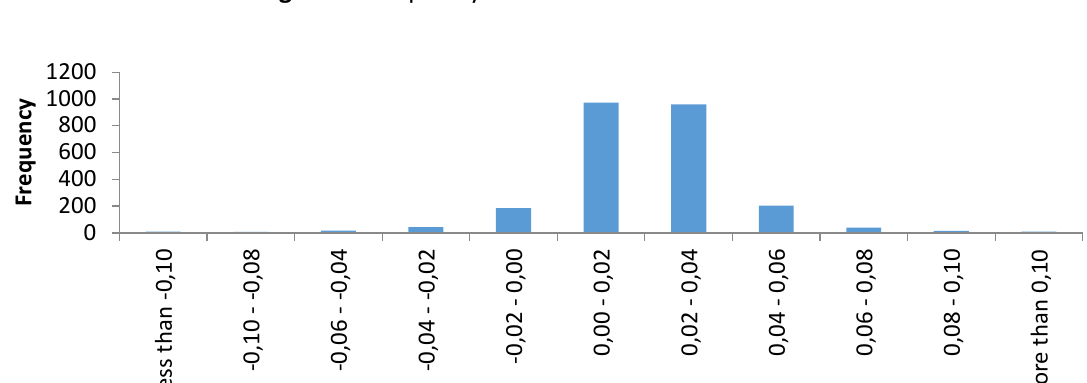
Figure 1. Frequency distribution for the PFTS index